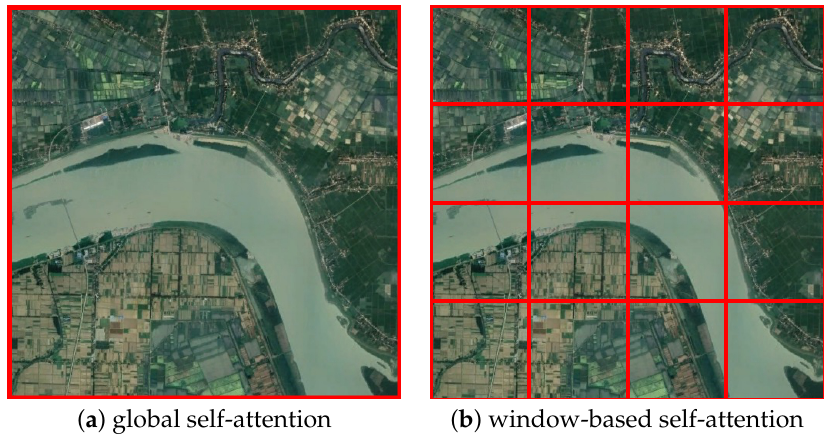
Figure 5. Global self-attention computes dependencies across the entire feature map. Window-based self-attention only calculates dependencies within the window range, so it can reduce the amount of